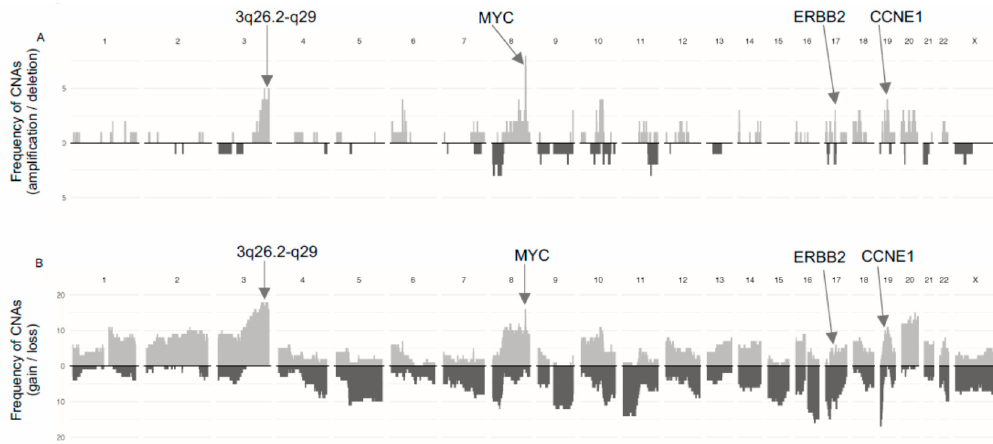
Figure 1. Frequency of Copy-Number Alterations (CNAs) sorted by ( A ) amplifications/deletions, and ( B ) gains/losses in the 19 tumors. Positions of frequently occurring driver genes are indicated with arrows [3,30]. Bars directed upwards represent amplifications/gains and bars directed downwards represent deletions/losses.